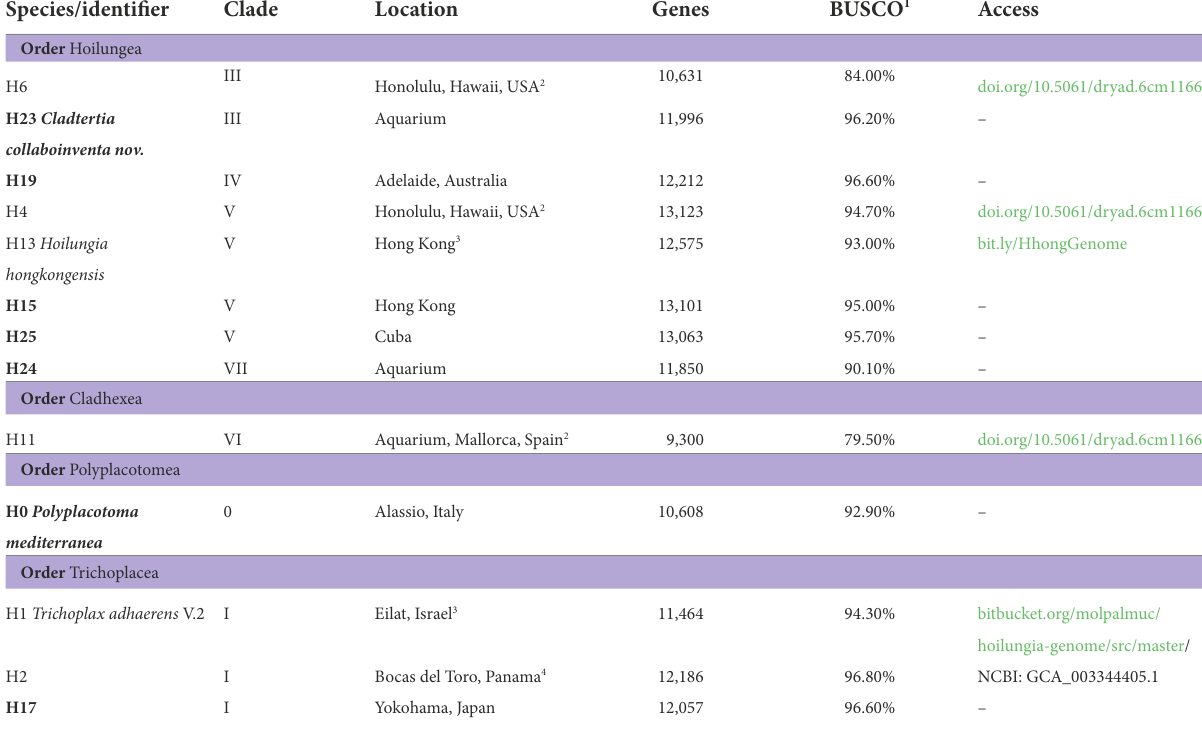
TABLE 1 Information on Placozoa genomic data used for phylogenomic reconstruction.